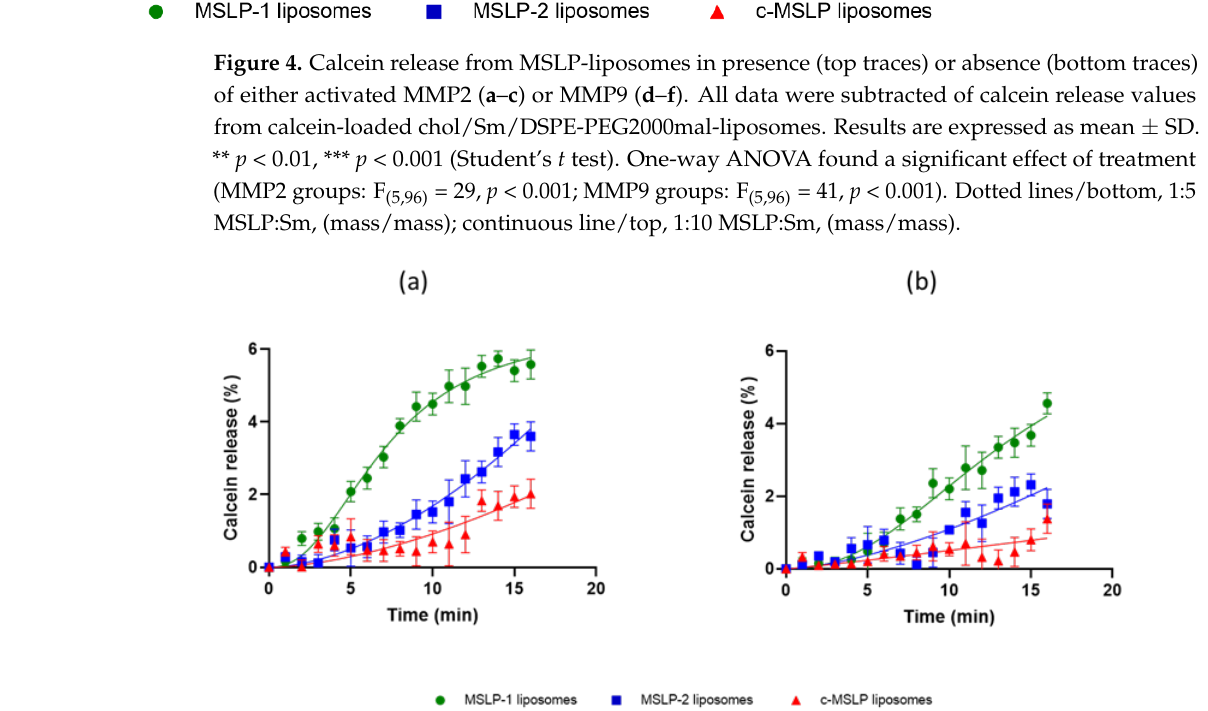
Figure 4. Calcein release from MSLP-liposomes in presence (top traces) or absence (bottom traces) of either activated MMP2 ( a – c ) or MMP9 ( d – f ). All data were subtracted of calcein release values from calcein-loaded chol/Sm/DSPE-PEG2000mal-liposomes. Results are expressed as mean ± SD. ** p < 0.01, *** p < 0.001 (Student’s t test). One-way ANOVA found a significant effect of treatment (MMP2 groups: F (5,96) = 29, p < 0.001; MMP9 groups: F (5,96) = 41, p < 0.001). Dotted lines/bottom, 1:5